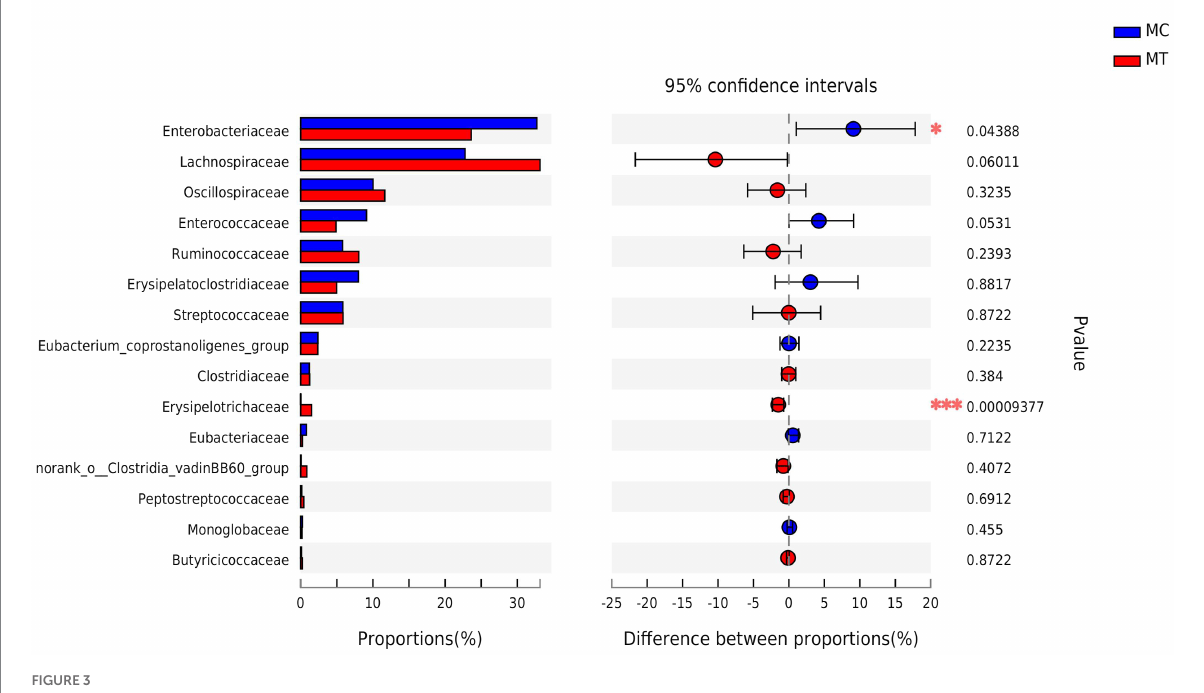
FIGURE 3 Difference analysis on Family